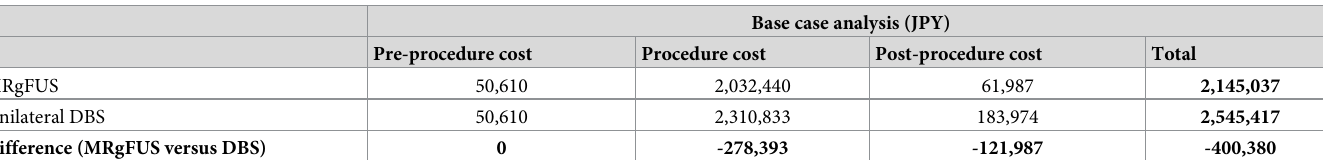
Table 1. Results of the base case